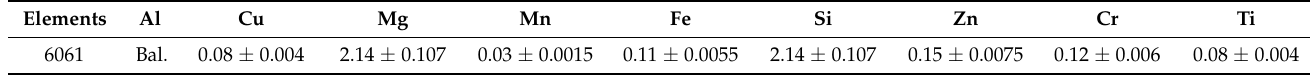
Table 2. Chemical composition of aluminum alloy AA6061 by X-ray fluorescence (wt. %). Elements